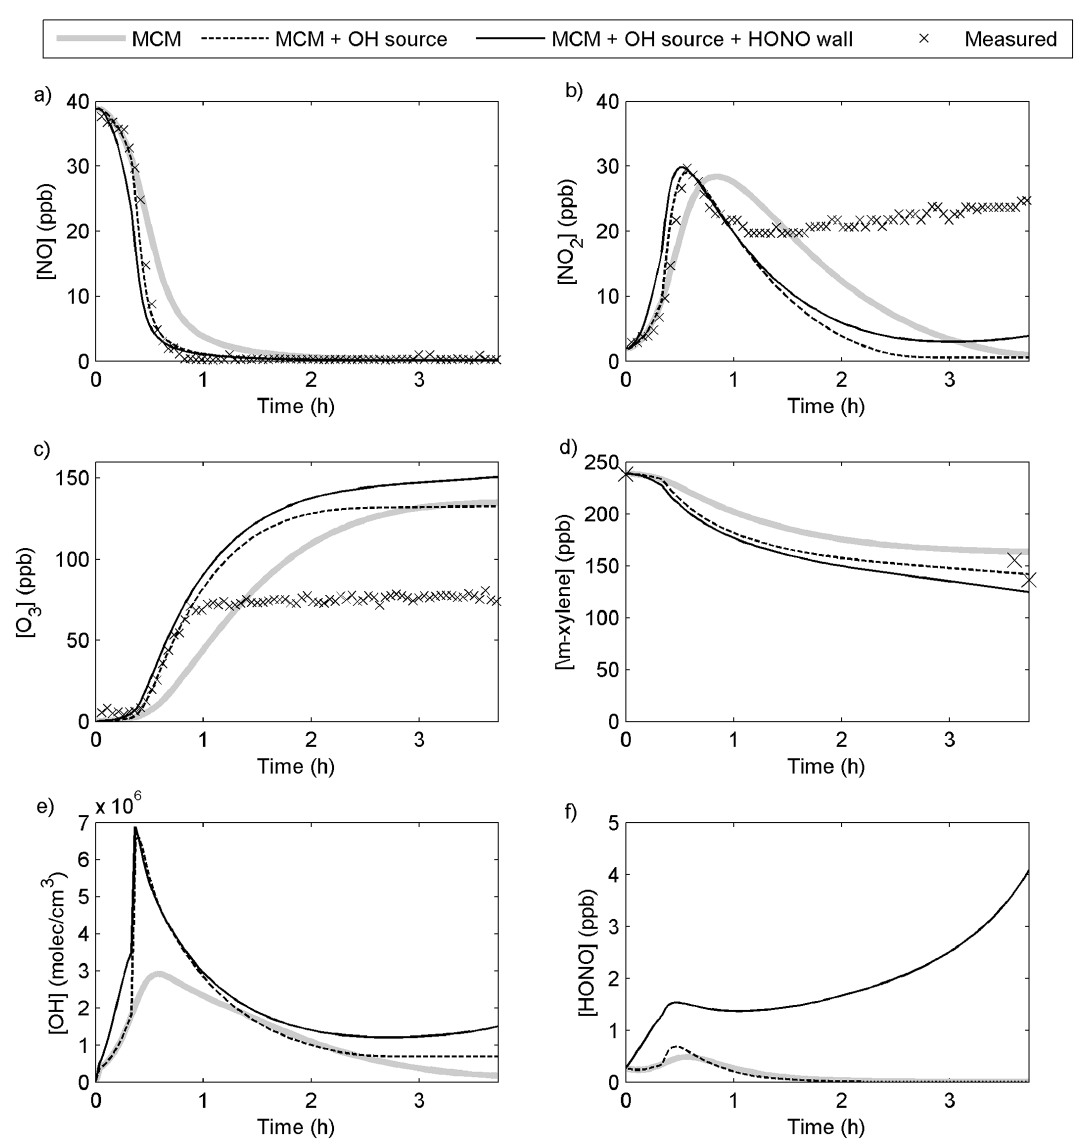
Figure 13. Modelled and measured gas-phase concentrations from the m -xylene oxidation experiment by Nordin et al. (2013). (a–d) give the modelled and measured NO, NO 2 , O 3 and m -xylene concentration, respectively. (e–f) show the modelled OH and HONO concentrations. The model results are from simulations with (1) the original MCMv3.2 gas-phase chemistry, (2) with MCMv3.2 gas-phase chemistry and an artificial OH source of 10 8 cm 3 s − 1 , and (3) with MCMv3.2 gas-phase chemistry, the artificial OH source and wall emissions of